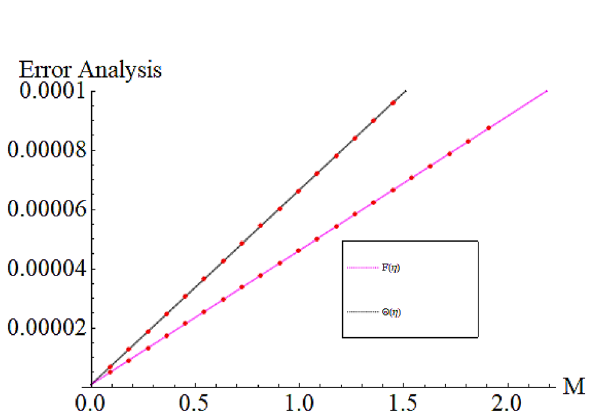
Figure 24. Parameter range M